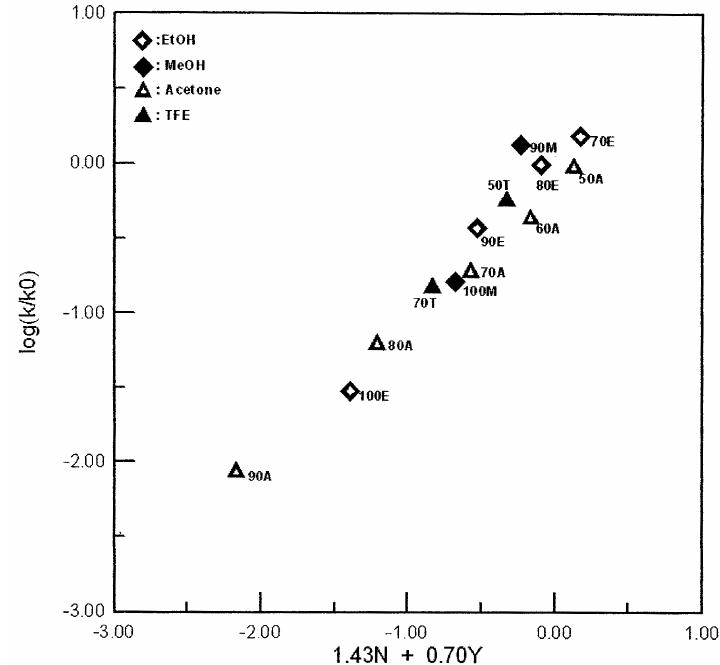
Figure 2. The plot of log(k/k ) vs. (1.43N + 0.70Y ) for the solvolyses of benzyl fluoroformate in 0 T Cl pure and binary solvents at 25.0 °C. The three TFE–ethanol systems are omitted from the correlation. In the key to symbols, only components other than water are